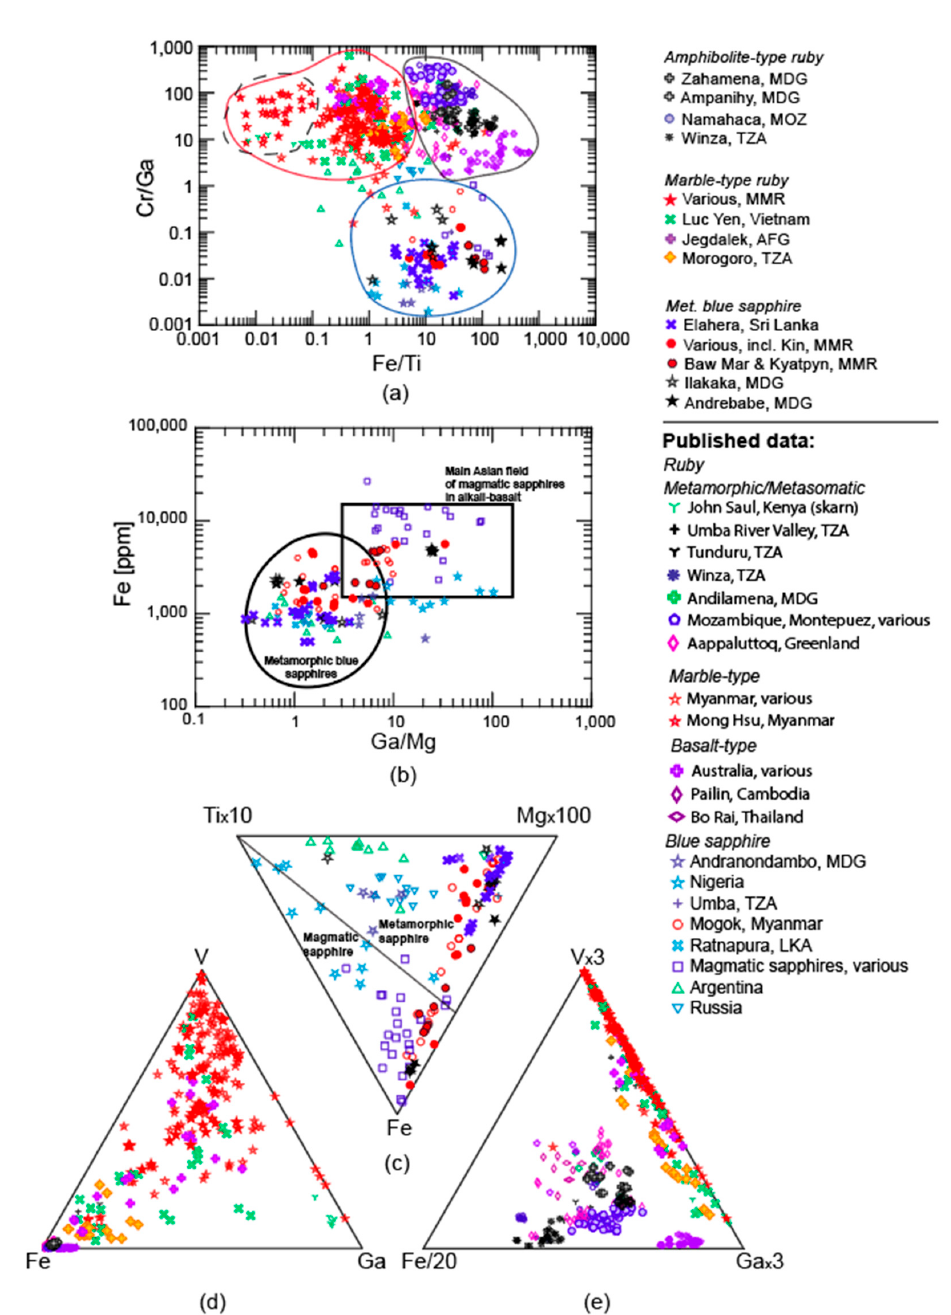
Figure 11. ( a ) Plot of Cr / Ga (ppm) versus Fe / Ti (ppm) (modified from [8]); fields are red = marble-type, black / dashed = Mong Hsu ruby [62], black = high Fe, and blue = blue sapphires. ( b ) Fe (ppm) versus Ga / Mg (ppm) (after [10]); ( c ) Mg × 100-Fe-Ti × 10 ternary plot modified after [10]; and ( d ) Fe-V-Ga ternary plot (after [15]), and ( e ) Fe / 20-V × 3-Ga × 3 (after [28]) in gem corundum analyzed in this study. All data plotted are laser ablation inductively coupled plasma mass spectrometry (LA-ICP-MS) values. Additional data from [10,23,25,33,42,43,59,60,62–69].